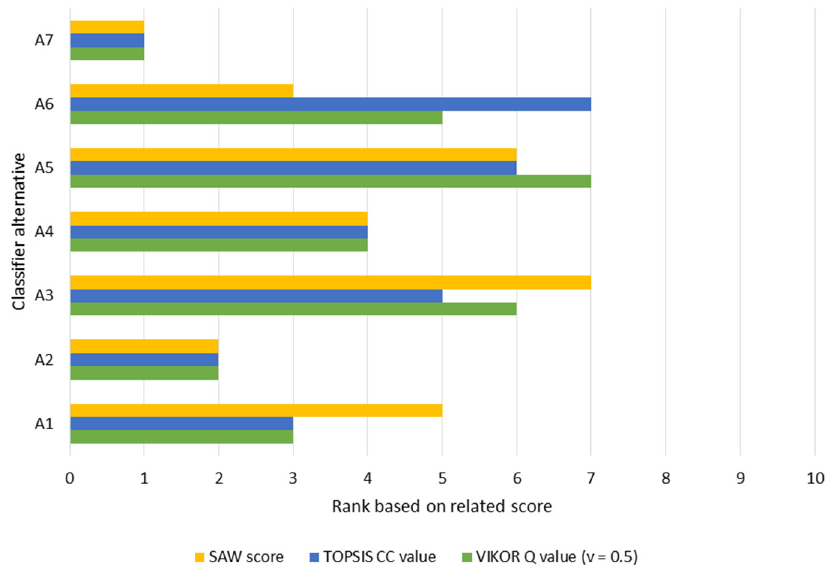
Figure 6. Contrast between SAW, TOPSIS, and VIKOR rankings.